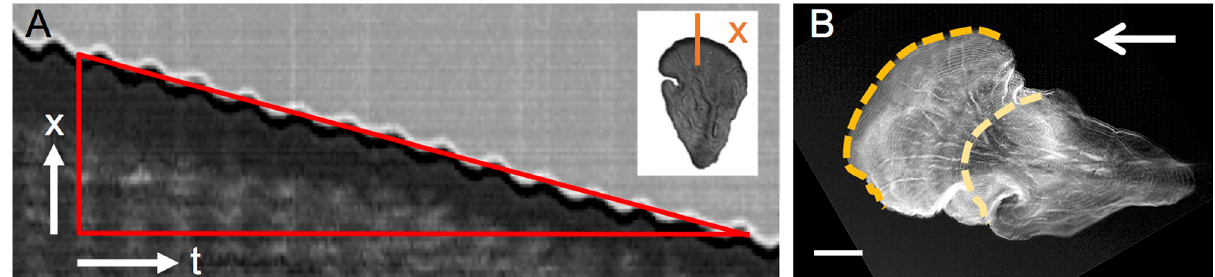
Fig 2. Kymograph. A) Kymograph of the growth front of a mesoplasmodium. x = spatial dimension, t = time. Inset: single frame of a time sequence. Kymograph is taken along orange line. B) Output image of a time series (standard deviation). Yellow dashed line = first frame of time series, orange dashed line = last frame. Scale bar = 20 μ m. Arrow denotes direction of